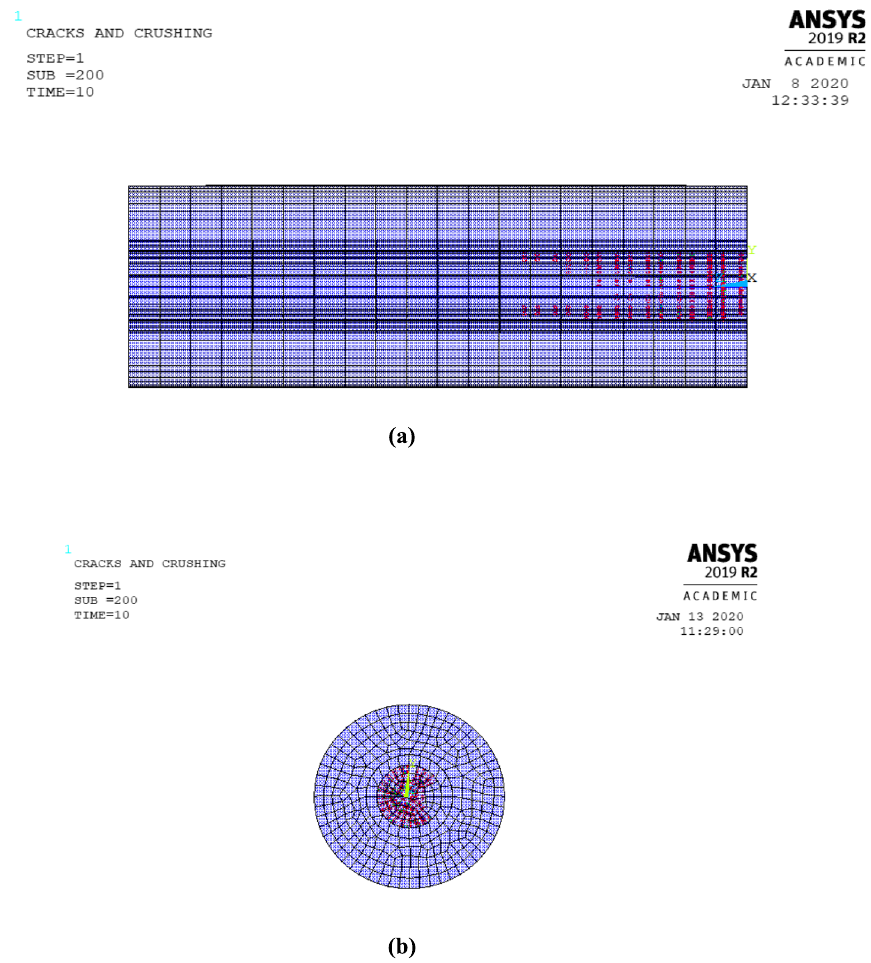
Fig. 16 a Crack pattern in model for static loading. b Crack pattern in model for static